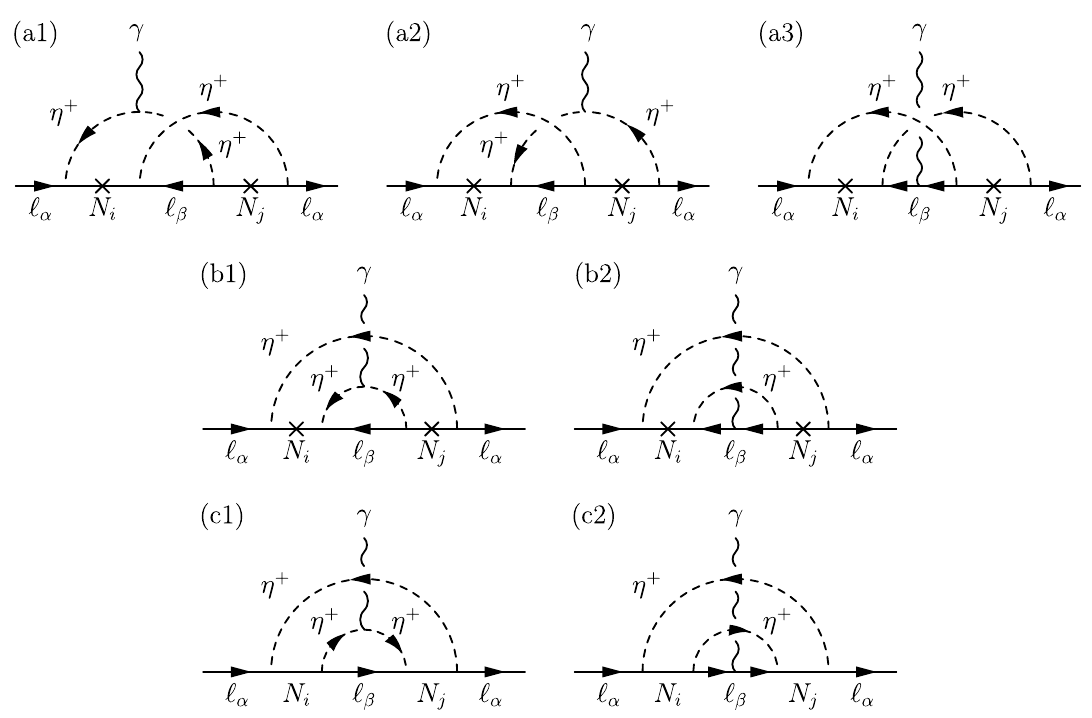
Figure 2 . Diagrams for charged lepton EDMs in the minimal scotogenic